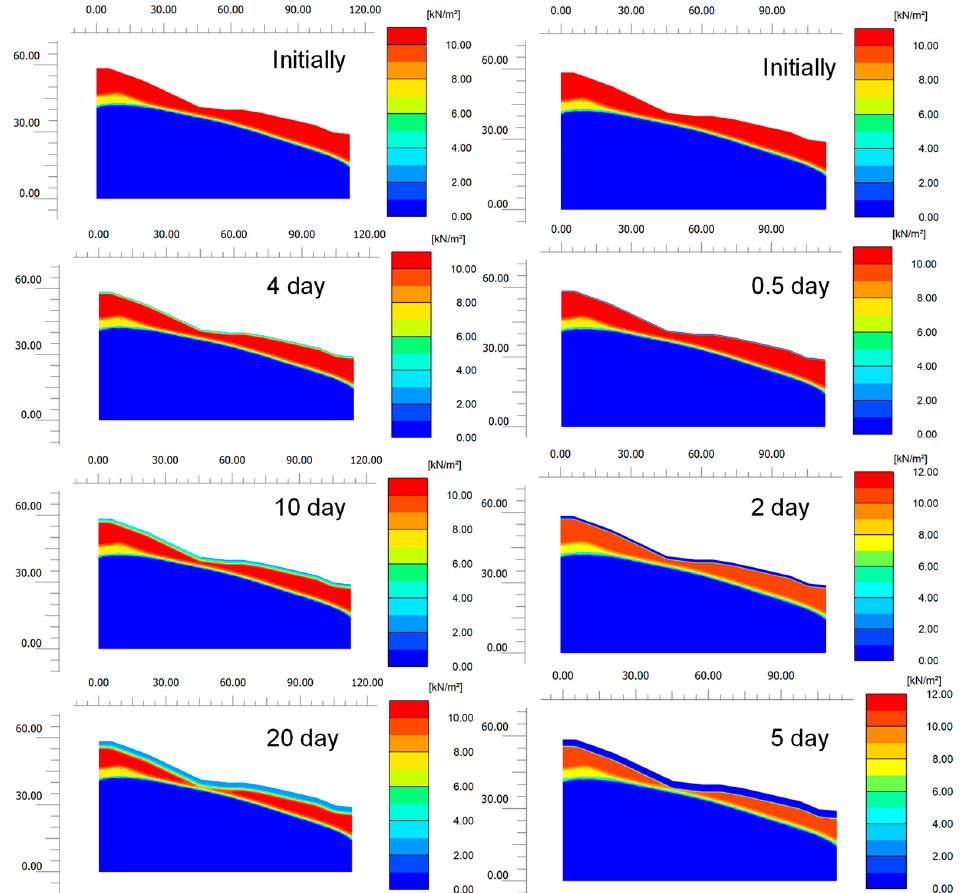
Figure 9. Distribution of suction within the slope on different days during the rainfall for the case without vegetation reinforcement: left with a rainfall intensity of 10 mm/day and right with a rainfall intensity of 50